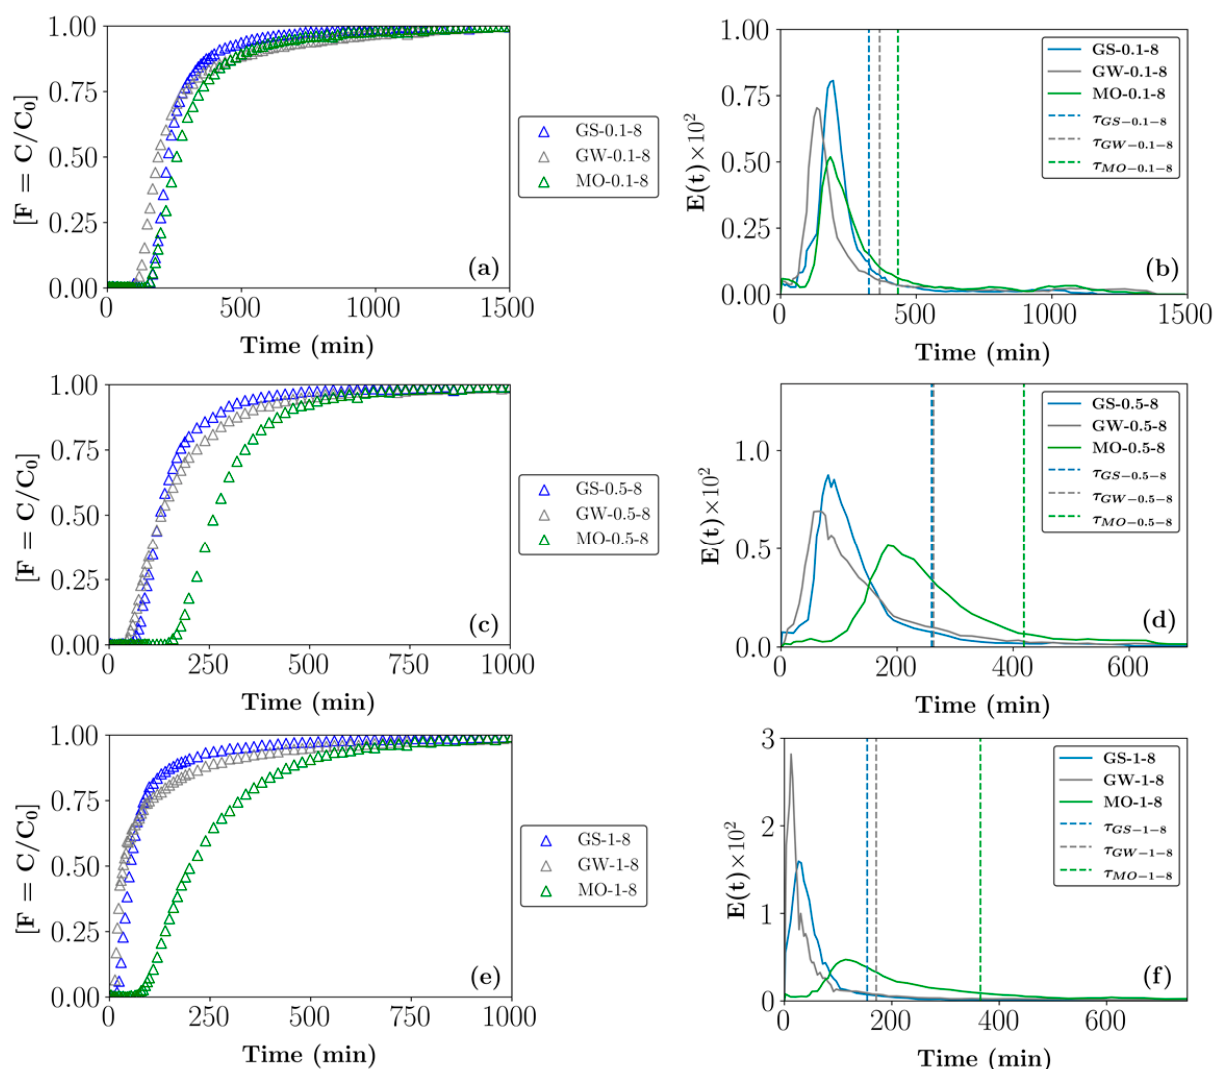
Figure 9. (Left—( a , c , e )) Cumulative (F(t)) and (right—( b , d , f )) exit age (E(t)) RTD profiles for beds composed of different size fractions of GSs, GW, and MO. The vertical lines in the E(t) curves represent the calculated average residence times. Key: GS/GW/MO- 0.1-8 (0.1–8 mm), 0.5-8 (0.5–8 mm), and 1-8 (1–8 mm).